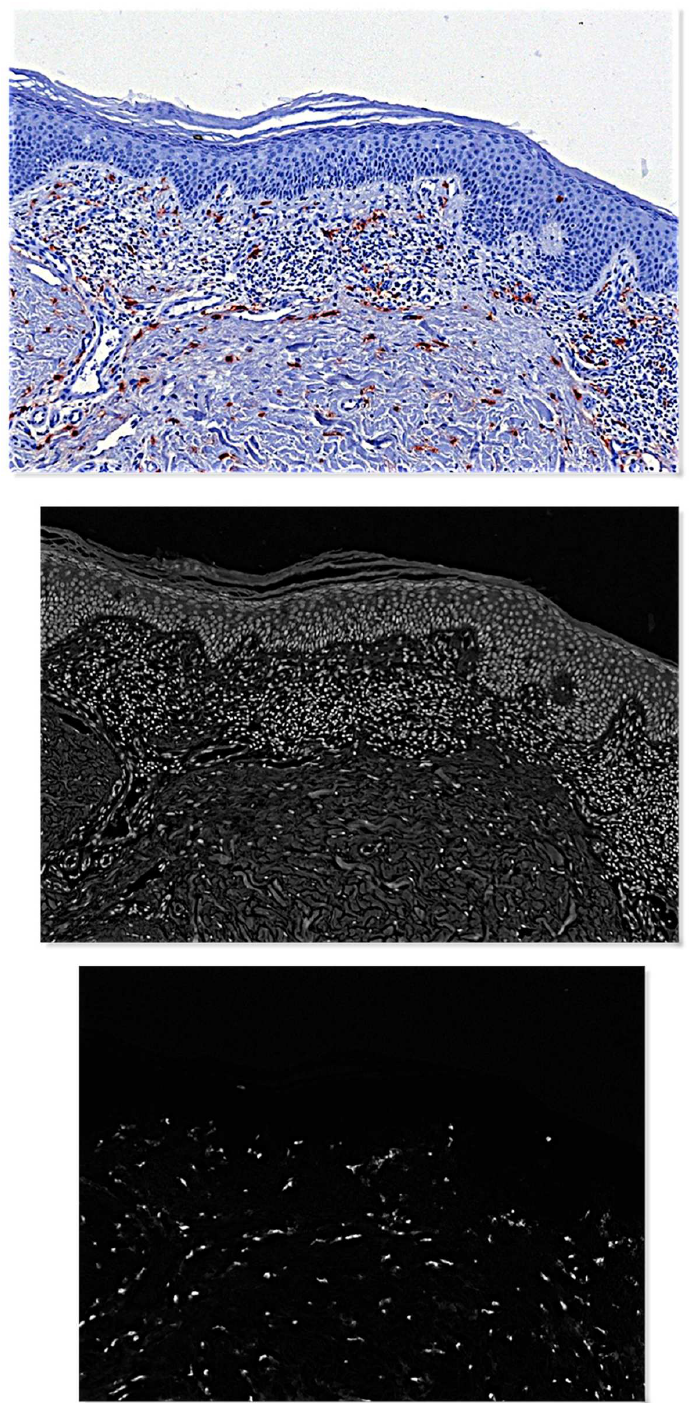
Figs 2a–c. Color deconvolution to seperatethe hematoxylin stained nuclei from tryptasepositive mast cells.